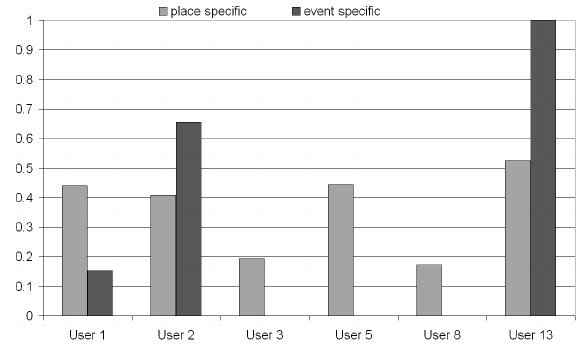
Figure 11. “Place Specific” vs. “Event Specific” results by